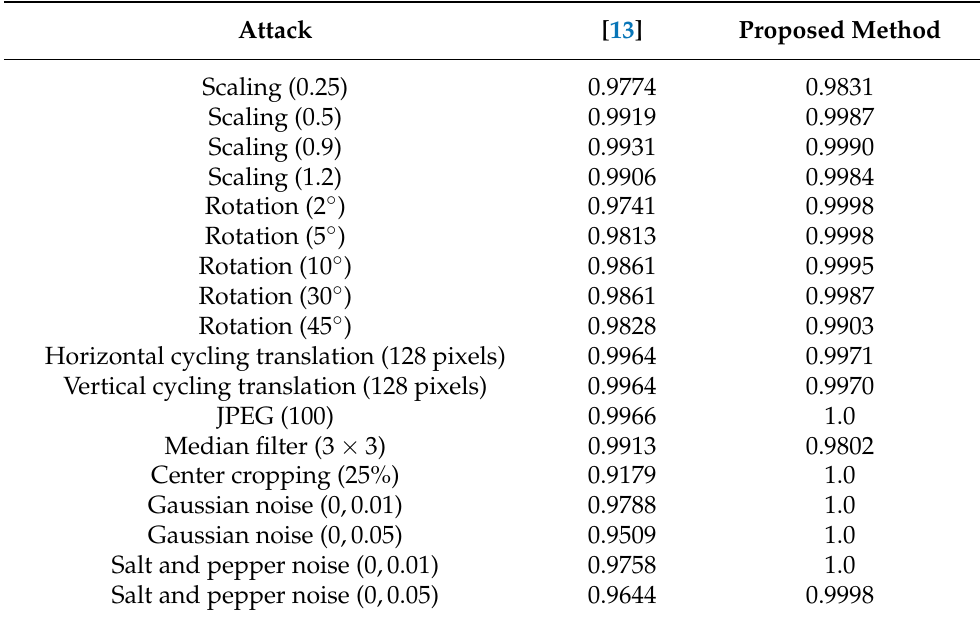
Table 16. Robustness comparison with [13] measured in terms of NC for